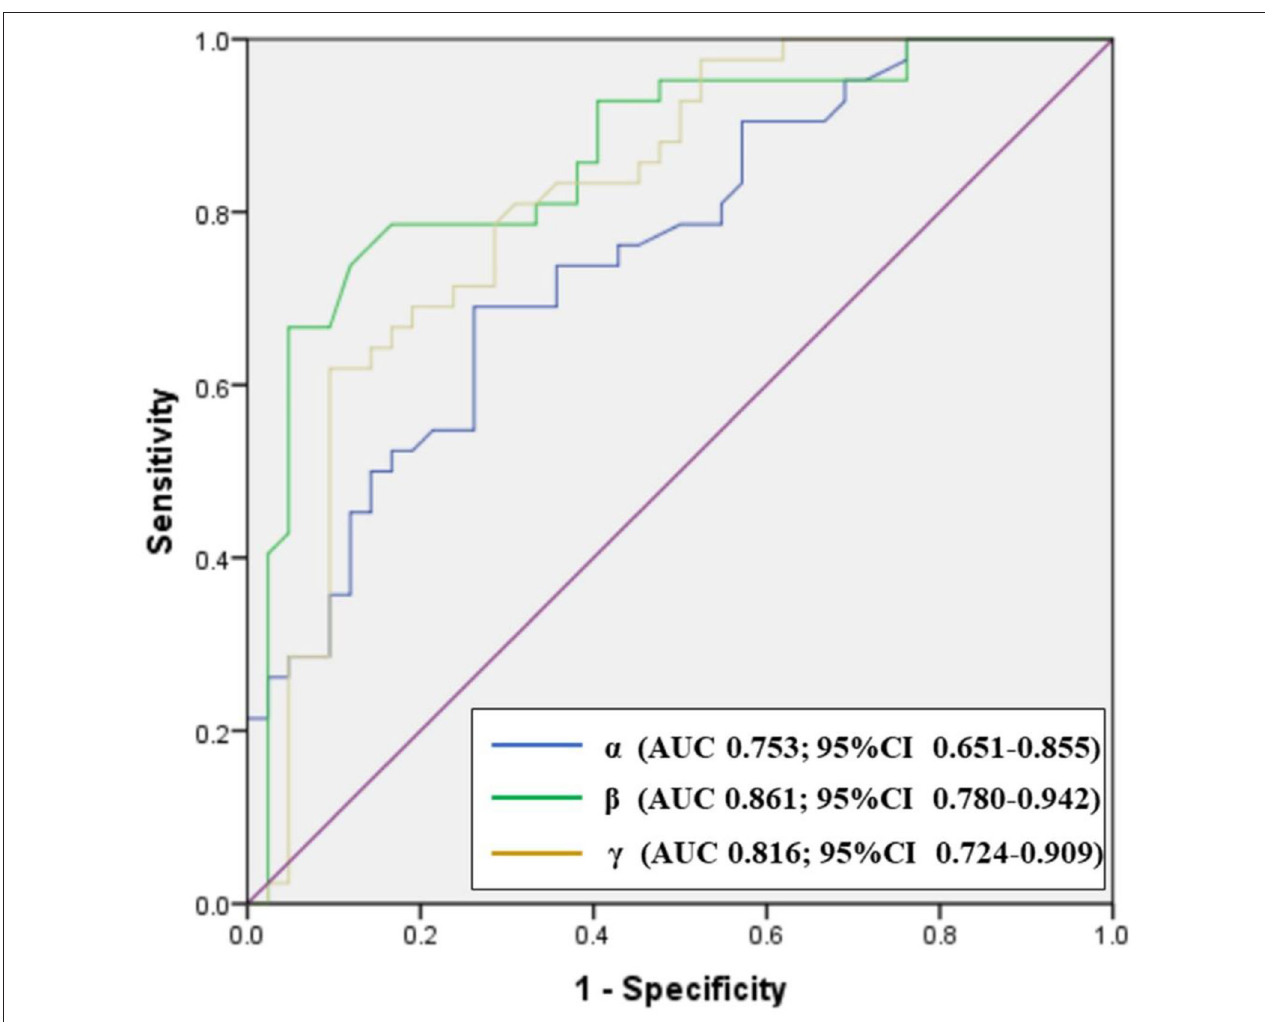
FIGURE 5 | Receiver operator characteristics (ROC) plot showing the performance of carotid siphon angles in discriminating between paraclinoid aneurysms groups and healthy control groups. CI: confidence interval.